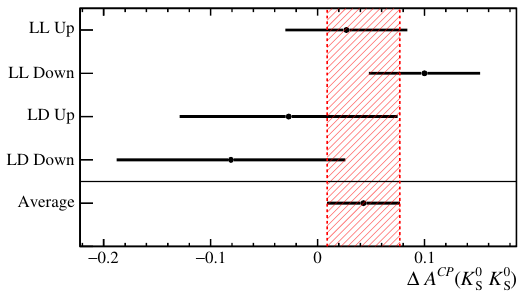
Figure 5 . Values of (cid:1) A CP obtained for both magnet polarities on the LL and LD samples, along with the average of these measurements. Only statistical uncertainties are